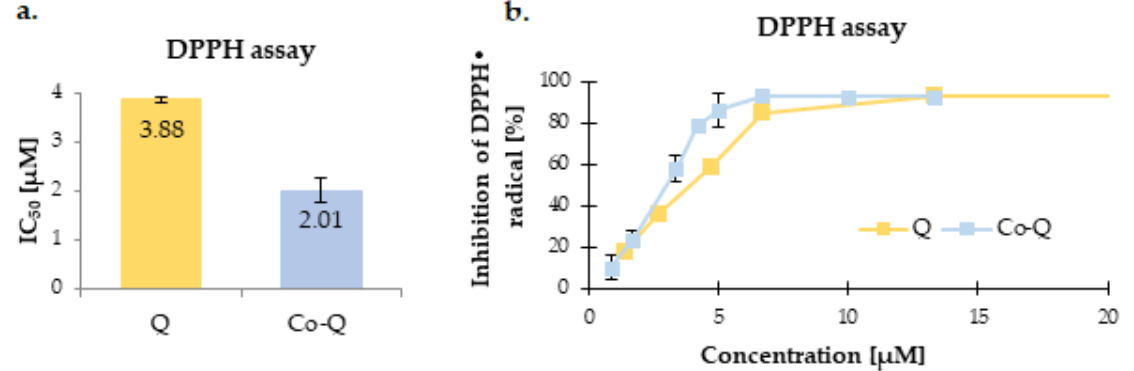
Figure 6. ( a ) The IC 50 values for quercetin (Q) and Co(II) complex of quercetin (Co-Q); ( b ) the scavenging of DPPH • by Q and Co-Q. Mean values from three independent experiments ± SD are shown.